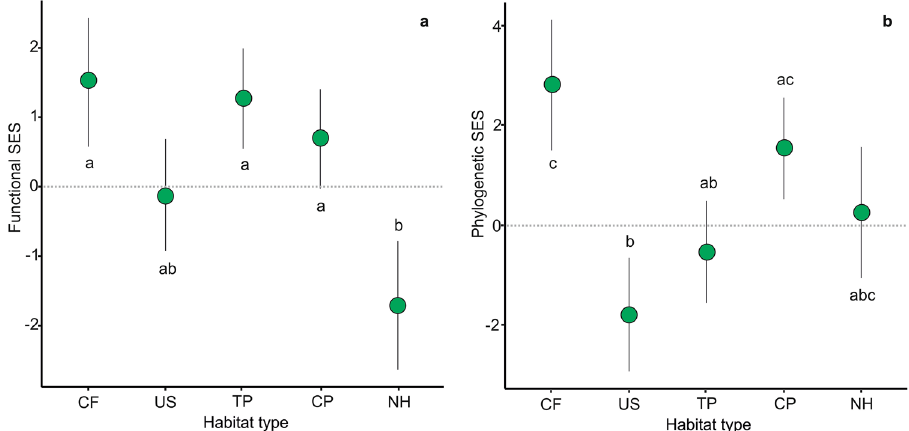
Figure 3. Differences in functional ( a ) and phylogenetic ( b ) SES among habitat types ( CF crop fields, US urban settlements, TP tree plantations, CP cattle pastures, NH natural habitats) in the Forest. Circles are means and bars are equivalent to confidence intervals of 95%. Different letters indicate significant differences ( P < 0.05) between pairs of habitat types: results of Tukey multiple comparisons of means through emmeans function of functional and phylogenetic SES between habitat